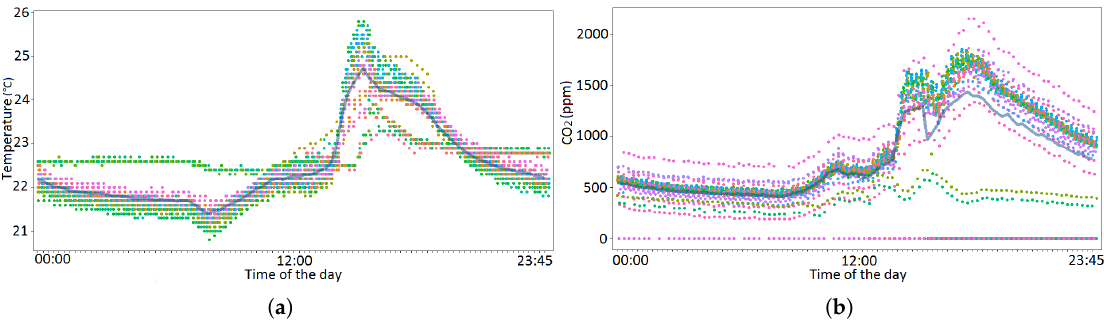
Figure 4. Uncomfortable temperature ( a ) and CO 2 ( b ) during one of the events (dots present the raw readings from different sensor nodes in the space).